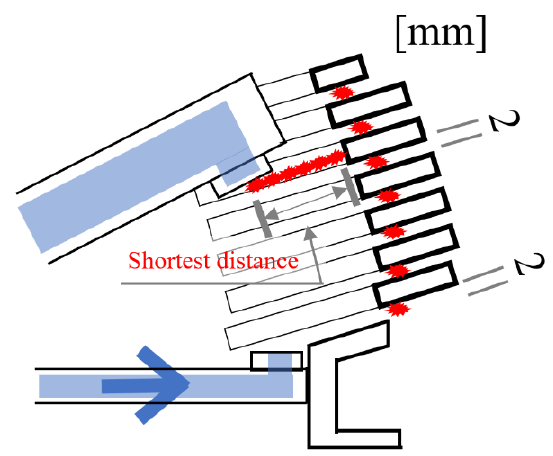
Figure 11. The shortest distance between the arc and splitter plate in basic state.